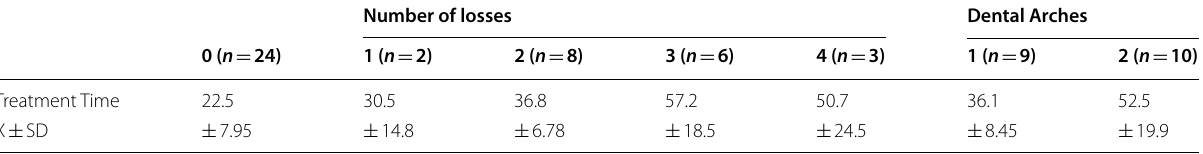
Table 2 Mean and standard deviation of treatment time according to the number of losses and number of arches involved